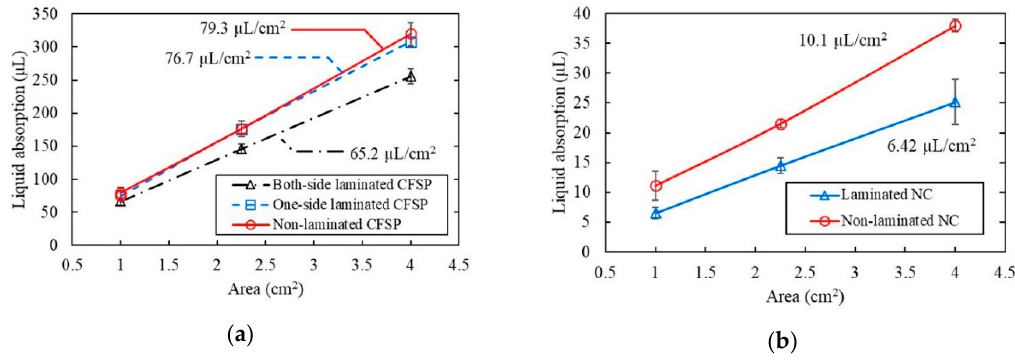
Figure 8. Comparison between our model and experiment data for ( a ) non-laminated NC paper and ( b ) laminated NC paper. Sample n = 3 for independent experiments. Table 7. Absorption capacity result from the model and direct weighting experiment comparing to literature.